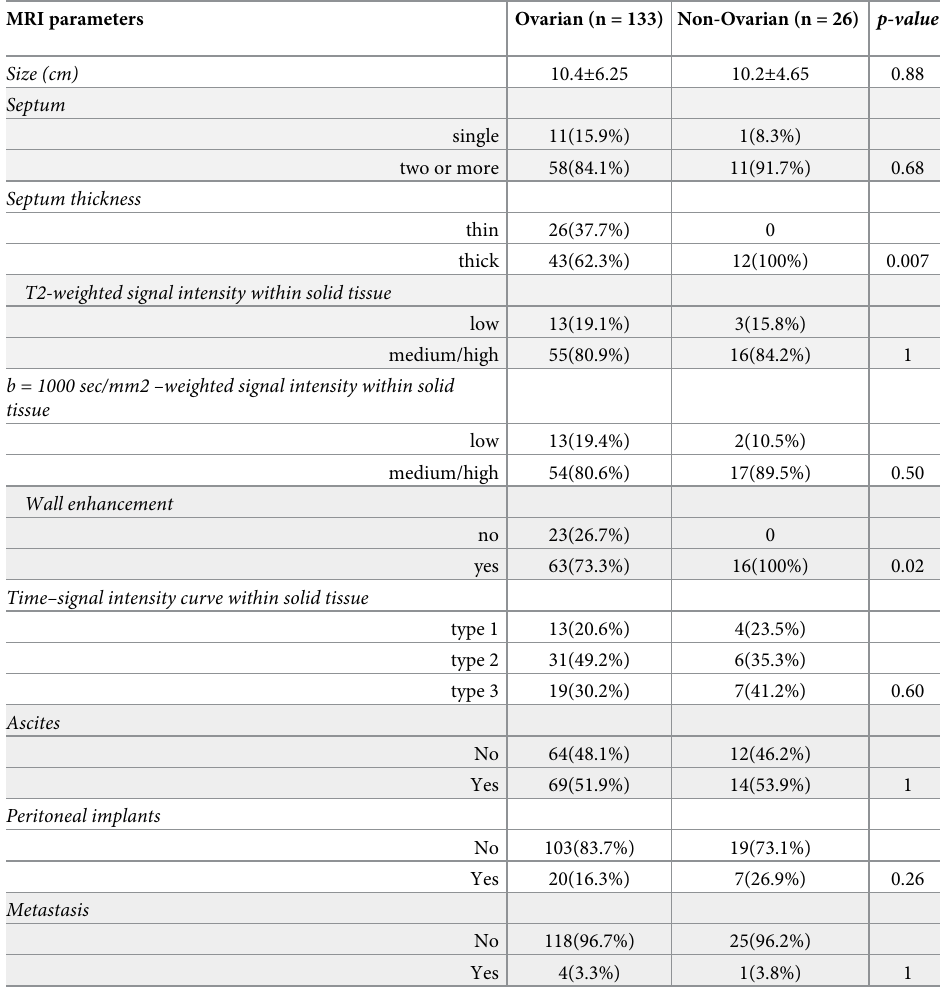
Table 3. Comparison of MRI parameters between ovarian and non-ovarian tumors.